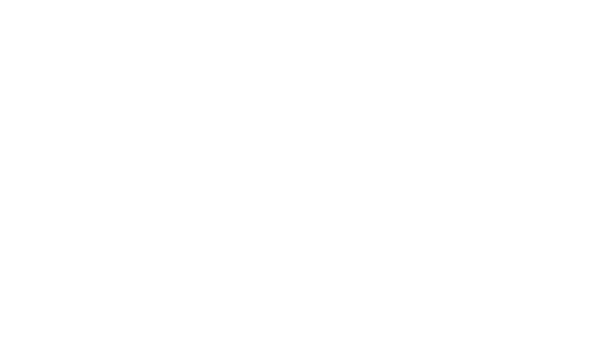
Figure 1. Optical filter of which transmittance can be controlled depending on the incident angles.